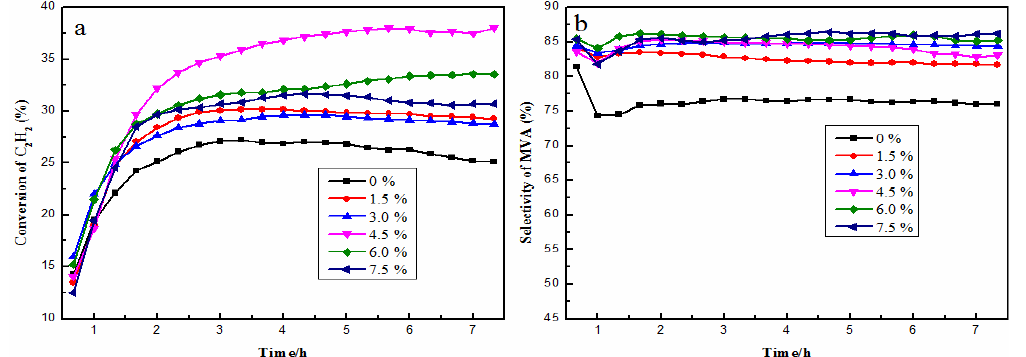
Figure 2. ( a ) Conversion of C 2 H 2 and ( b ) selectivity to MVA in acetylene dimerization over 0–7.5% of L 1 . (Reaction conditions: Space velocity of acetylene 105 h − 1 , reaction temperature 80 ◦ C). Table 2. Effect of the amount of L 1 for acetylene dimerization.